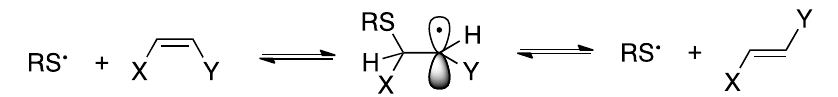
Figure 6. Reaction mechanism for the cis–trans isomerization of a double bond catalyzed by thiyl radicals.